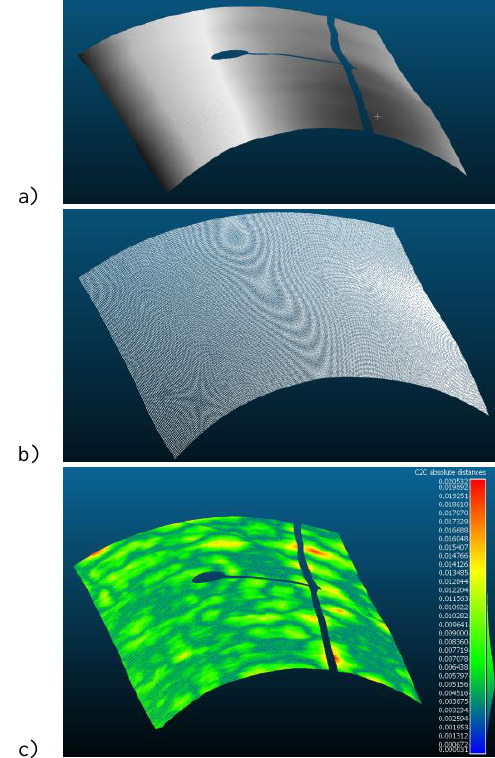
Figure 11. Results for a historic barrel vault: (a) provides a visualization of the original point cloud and the occlusion caused by a wire and a chandelier; (b) illustrates the recovered point cloud evaluated on a 0.01 m x 0.01 m grid; (c) provides a comparison between original and recovered point clouds, obtaining a final discrepancy of 0.006±0.003 m.